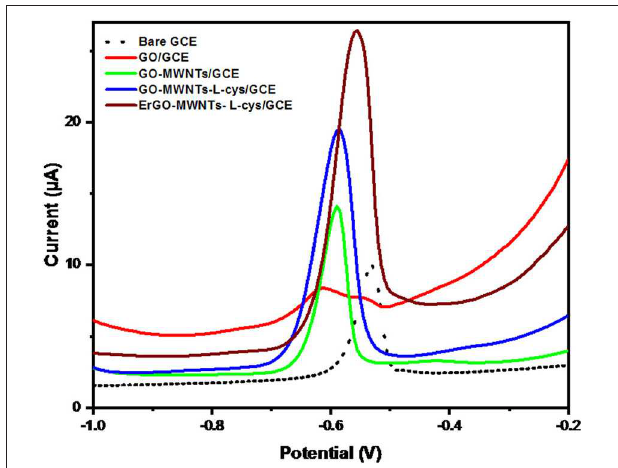
FIGURE 9 | The DPASVs for 50 µ gL − 1 Pb 2 + at the bare GCE (dot line), GO/GCE (red line), GO–MWNTs/GCE (green line), GO–MWNTs–L-cys/GCE (blue line), and ErGO–MWNTs–L-cys/GCE (brown line) under optimal conditions.